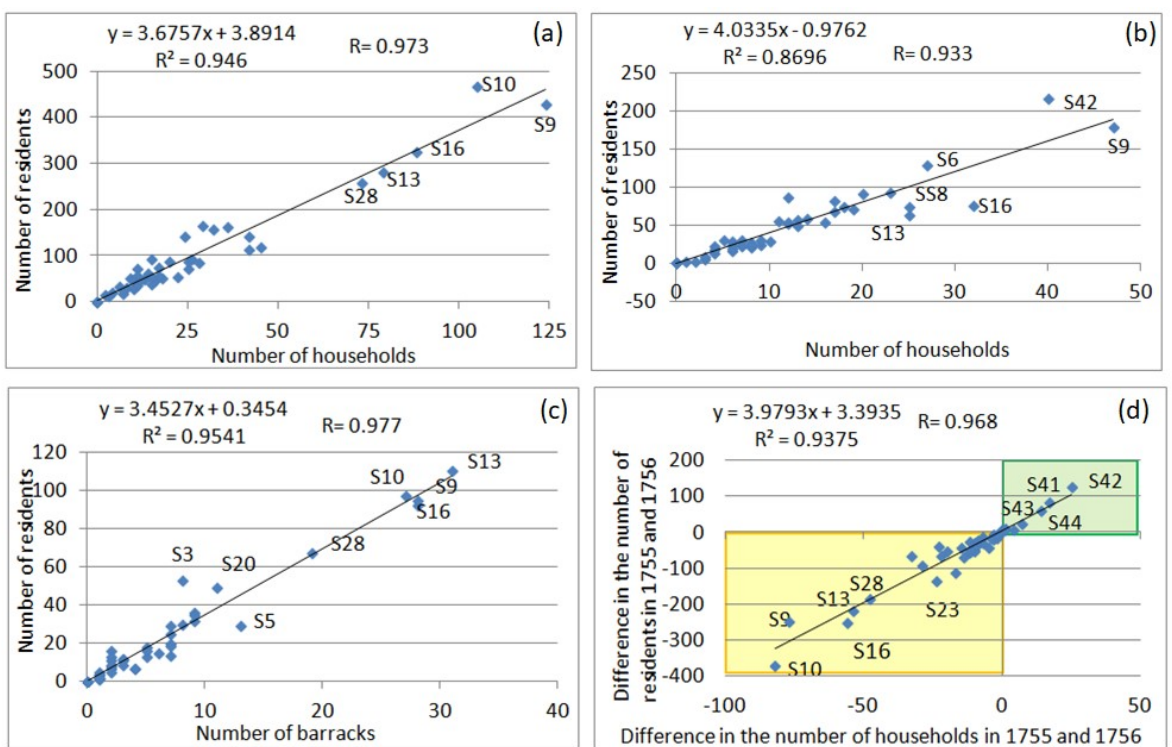
Figure 8. Comparison between the number of residents living in households and barracks on each street of Santo Estevão: ( a ) Residents living in households in 1755; ( b ) residents living in households in 1756; ( c ) residents living in barracks in 1756; ( d ) difference between residents living in households in 1755 and 1756. Green area means an increase in the number of residents and households, and yellow area means a decrease in the number of residents and households. List of street names and land uses indicated in Figure 4.